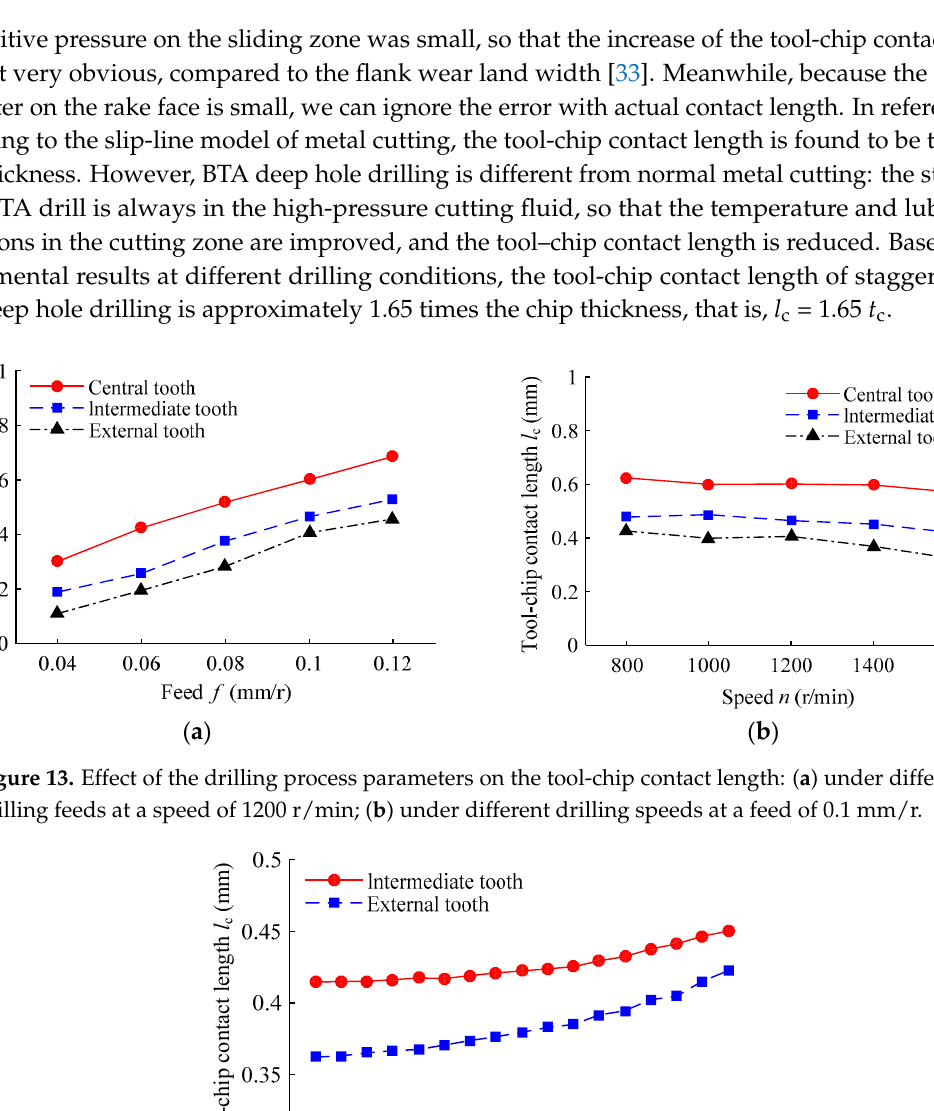
Figure 14. Effect of the drilling depth on the tool-chip contact length.